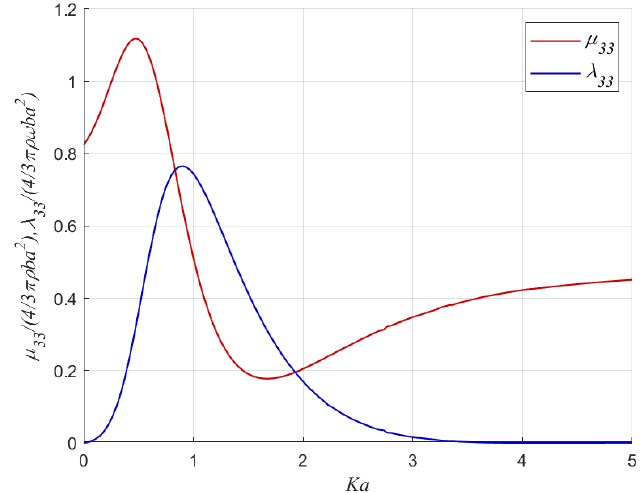
Figure 7. Normalized hydrodynamic coefficients in heave for a/b = 1.25, f = 1.01a and h = 5a. Further, the discussion is extended to the effect of the immersion below the free sur- face on the surge and the heave hydrodynamic coefficients. The model is a spheroid with slenderness ratio 𝑎/𝑏 = 1.1 , in a liquid field of ℎ = 10𝑎 . Three different immersions, 𝑓 , are examined, i.e., 1.01𝑎, 1.5𝑎 , and 3𝑎 (Figure 8 and 9). In fact, the conclusions drawn previously for the 𝑎/𝑏 = 1.25 apply for 𝑎/𝑏 = 1.1 , as well.